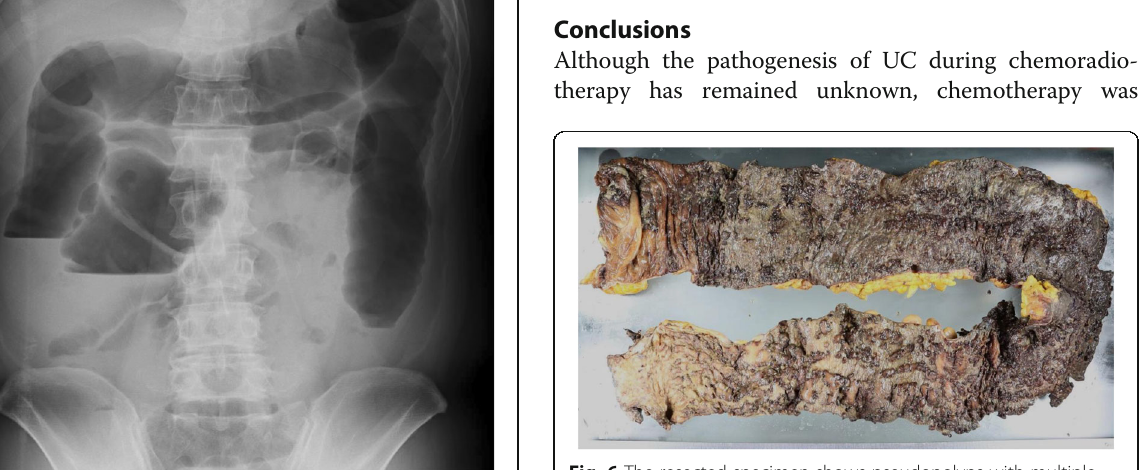
Fig. 6 The resected specimen shows pseudopolyps with multiple deep ulcerations from the dentate line to the